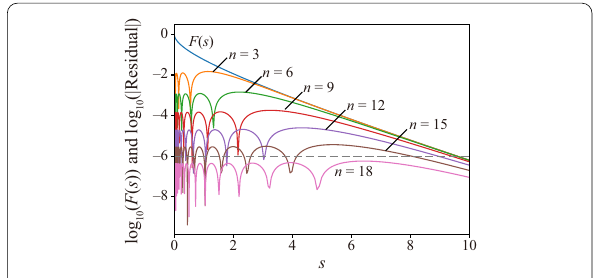
Fig. 3 F ( s ) and the residual of the numerical approximation of F ( s ) (Eq. (20)). The absolute error was less than 10 − 6 with n =